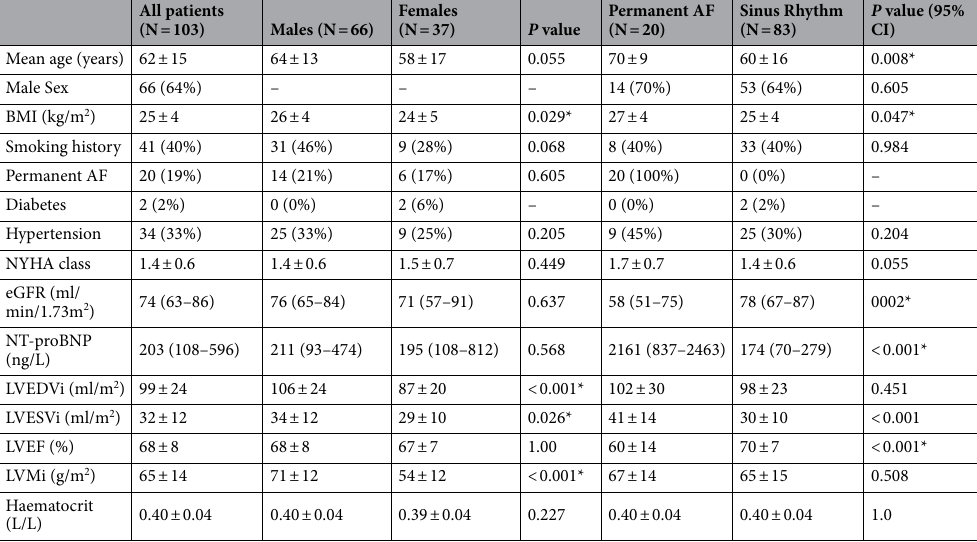
Table 1. Baseline demographics of the population studied, including subgroups (males, females, AF and sinus rhythm). Values represent mean ± standard deviation or median (IQR). BMI body mass index, AF atrial fibrillation, NYHA New York Heart Association, eGFR estimated glomerular filtration rate, NT-proBNP N-terminal pro B-type natriuretic peptide. P values with a * denotes statistical